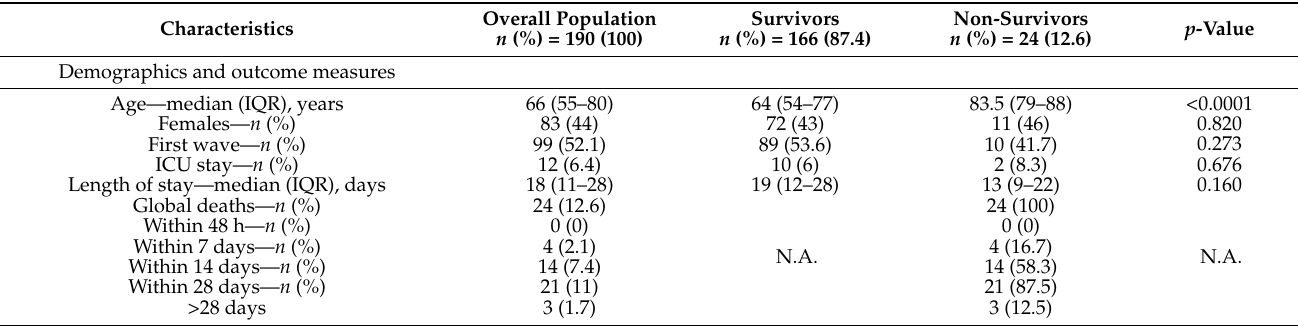
Table 1. General characteristics of study